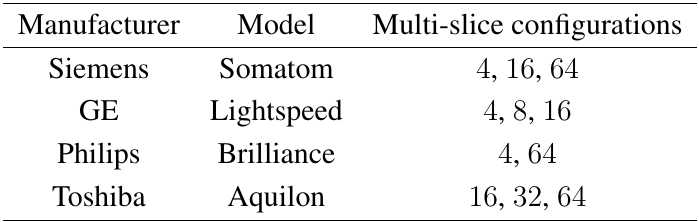
Table 2. Scanning equipment used to produce the